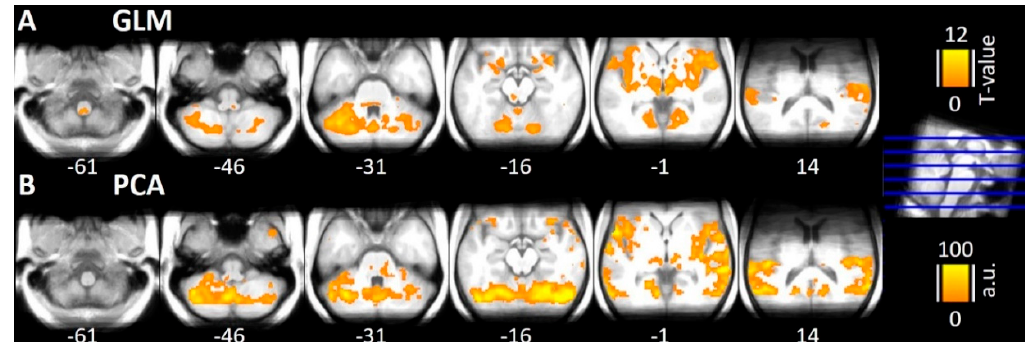
Figure 2. ( A ) Results of the trial-by-trial GLM analyses, which provides the basis for the proposed Similarity and Partial Similarity analysis. For visual inspection, results are shown using an uncorrected statistical threshold of p < 0.0001. The results confirm previously published condition-wise calculated GLMs [29,30,34]. ( B ) Normalized weights of the 1st component of the Principal Component Analysis (PCA), which explains nearly 10% of the concatenated beta-images resulting from the GLM analysis shown in the top row. Most of the known hubs of trigeminal nociception like STN, PAG, rostral Pons, Thalamus, and Cerebellum are involved. These unsupervised results underline the potential of analyzing trial-by-trial variations.